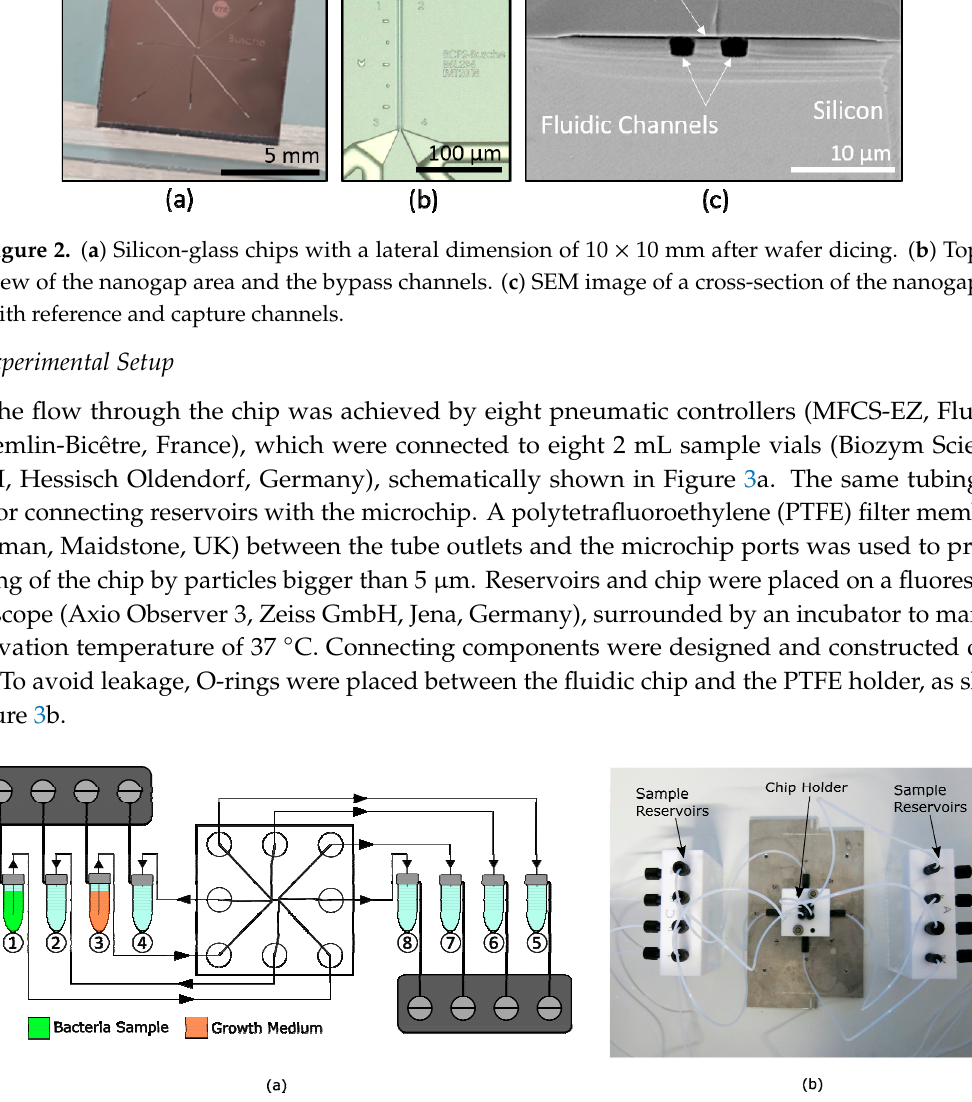
Figure 3. ( a ) Schematic of the fluidic setup with magnified bypass cross-flow (BCF) chip in the middle connected to sample and waste reservoirs and pressure controllers over the polytetrafluoroethylene (PTFE) tubing, driven by compressed air. Vials 1 and 3 are filled with bacteria sample and growth medium, respectively. Vials 2, 4, and 5–8 serve as waste reservoirs. ( b ) Fluidic setup with mounted chip in chip holder connected to the sample reservoirs.